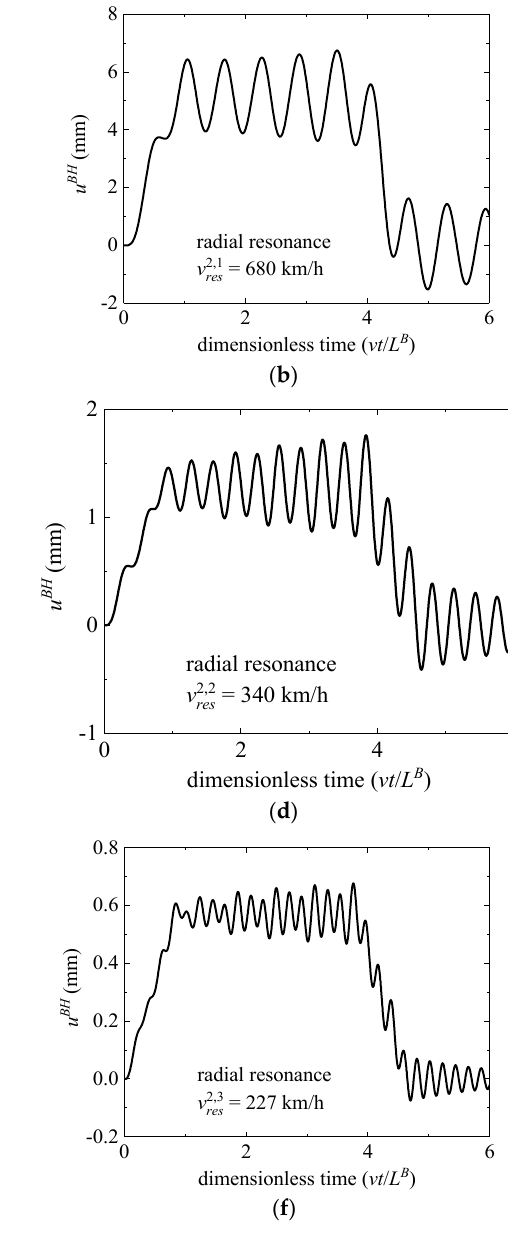
Figure 8. Time-history response of the bridge spanning 30 m under resonant velocity: ( a ) 1st vertical resonance; ( b ) 1st radial resonance; ( c ) 2nd vertical resonance; ( d ) 2nd radial resonance; ( e ) 3rd vertical resonance; ( f ) 3rd radial resonance